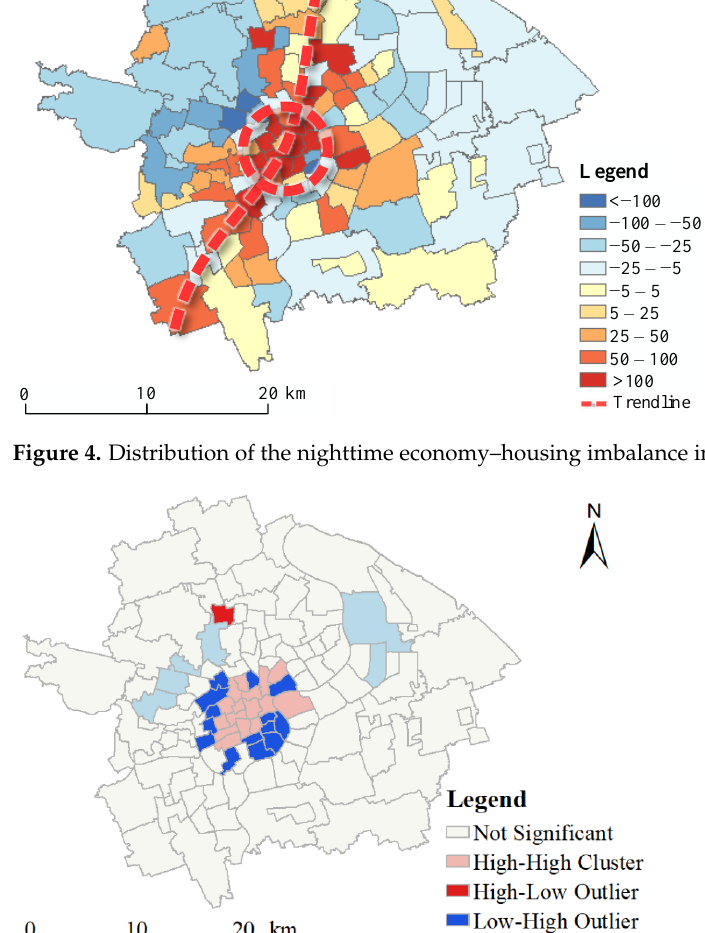
Figure 5. Local autocorrelation analysis results for the imbalance intensity